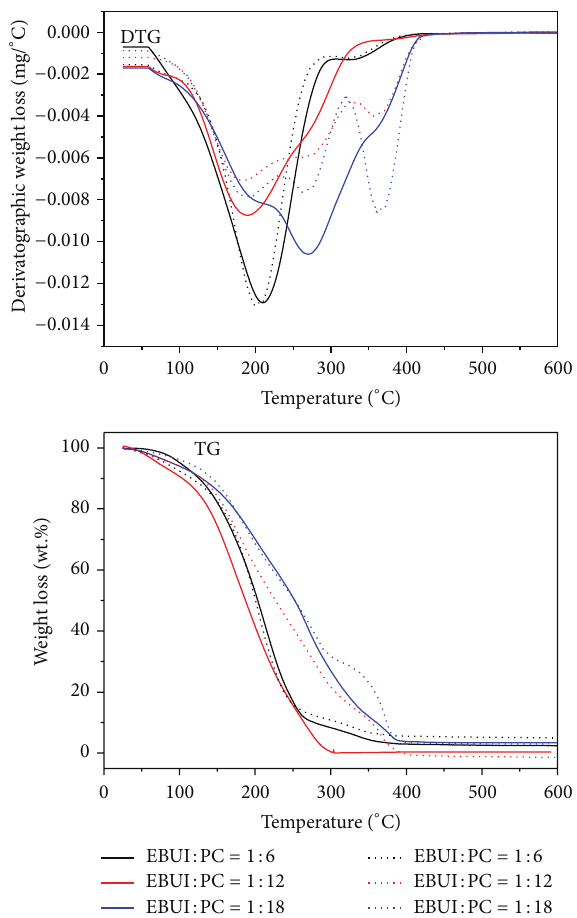
Figure 6: Thermogravimetry analysis of reaction products of EBUI and EBUII with excess of PC.